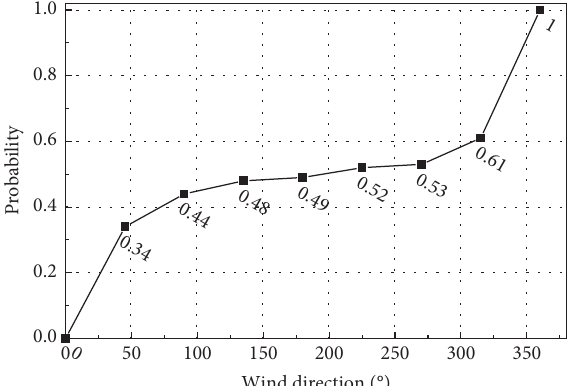
Figure 16: Wind direction cumulative distribution function in West Africa Sea.